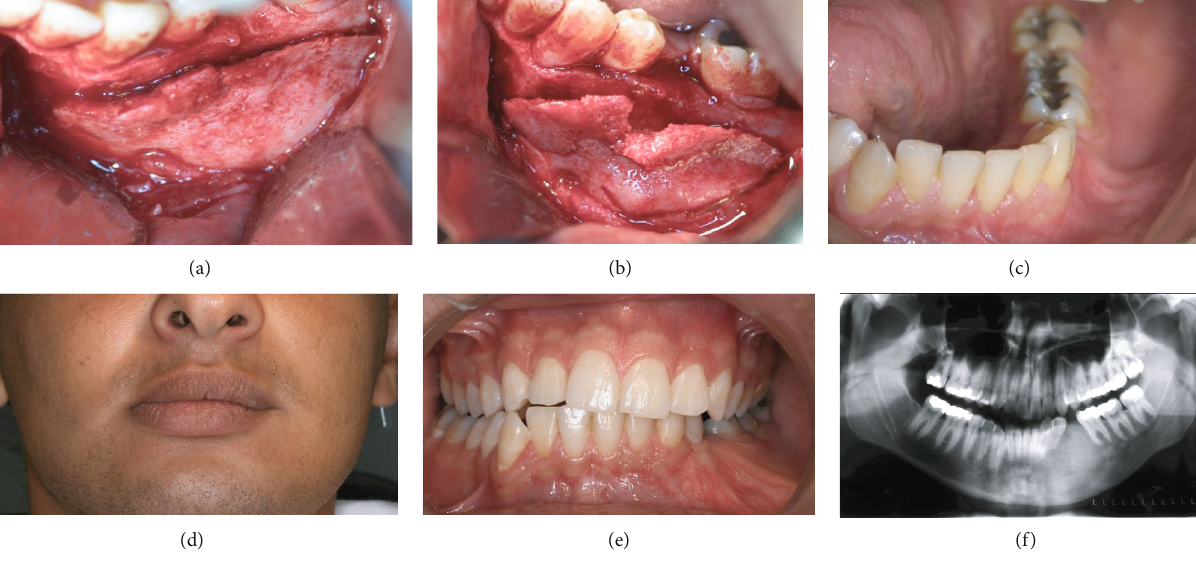
Figure 4: (a) Intraoperative view for the surgical approach. (b) The excised bone with respect to the mental foramen. (c) Healing of the soft tissue one month later. (d) Facial stability after 5 years following the second surgery and 15 years after the fi rst surgery. (e) Clinical appearance of the soft healing after 15 years of the fi rst surgery. (f) Panoramic X-ray after 15 years of the fi rst